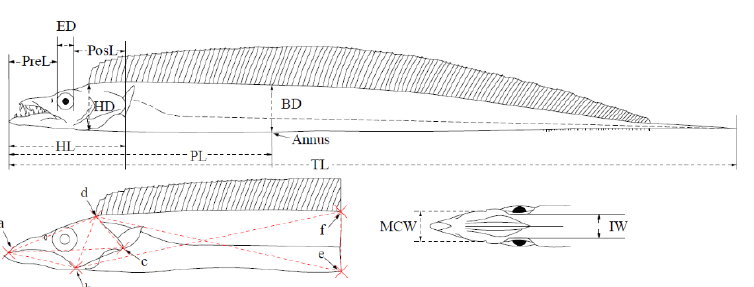
Figure A1. Measurements of morphological characteristics of hairtail for species identification. ED: